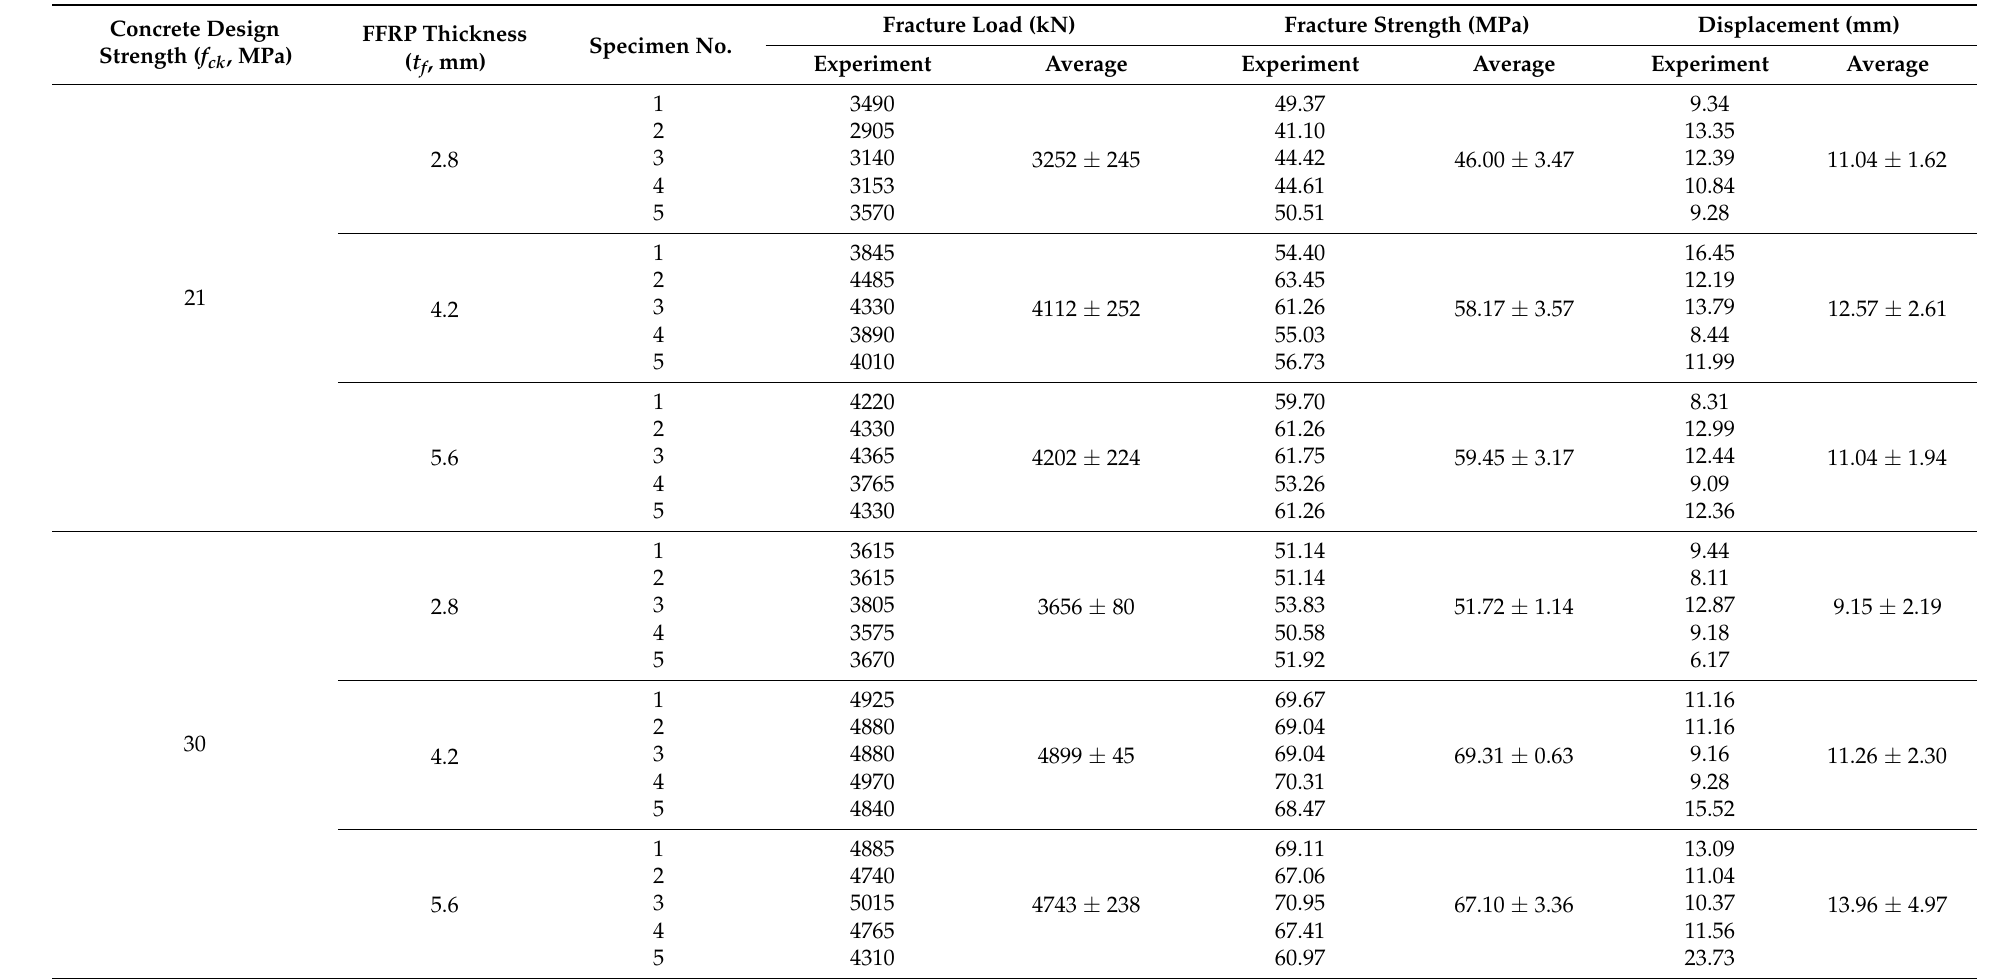
Table 9. Results of compressive strength testing of the